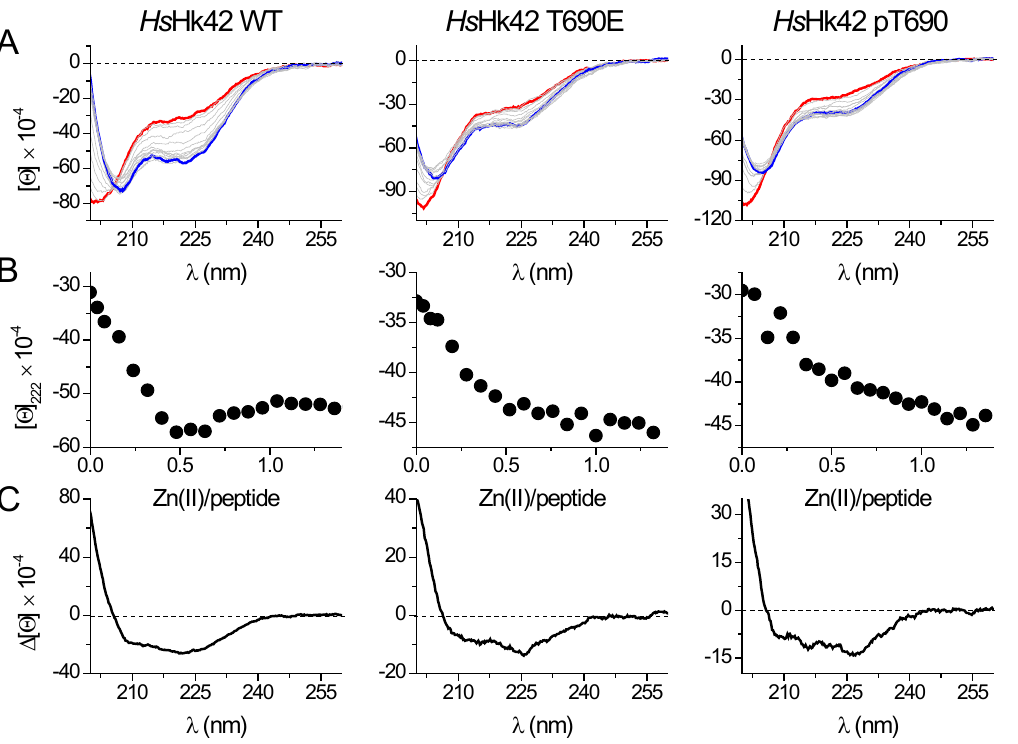
Figure 3. Zn(II) binding to 42-amino-acid long Hs Hk peptides registered by spectropolarimetry in 20 mM Tris-HCl buffer, pH 7.4, 100 mM NaF. ( A ) CD spectra of the apo-form of the peptides are shown as a red line, and the complex at a 0.5 molar ratio is shown as a blue line. ( B ) Molar ellipticity changes measured at 222 nm in the function of Zn(II)/peptide molar ratio. ( C ) Differential CD spectra for Hs Hk42 peptides were obtained by subtracting the apo-form spectra from the spectra of complexes at a 0.5 molar ratio. [ Θ ] corresponds to molar ellipticity in deg × cm 2 × dmol − 1 . Contrary to 42-amino-acid-long peptide models, direct CD titrations of both metal-free Hs Hk183 and phosphomimetic Hs Hk183 T690E with Zn(II) show extensive